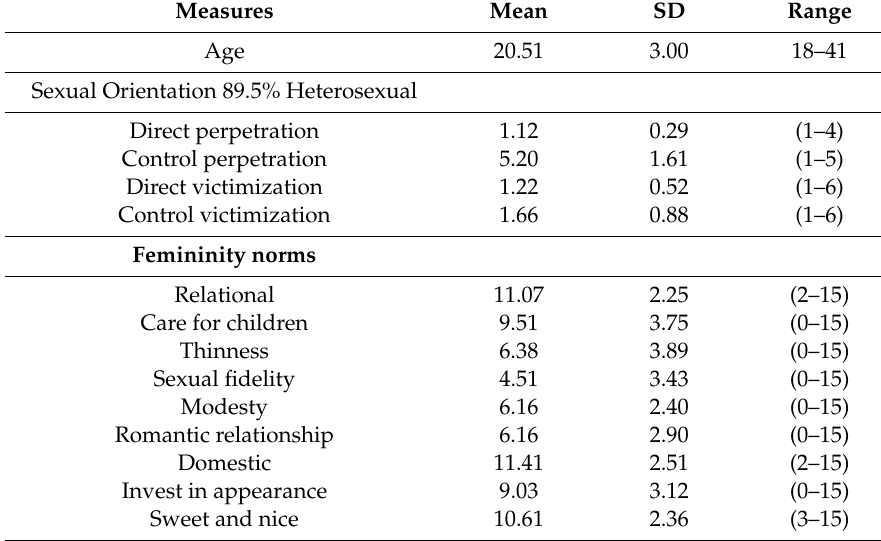
Table 1. Summary statistics of the study variables.